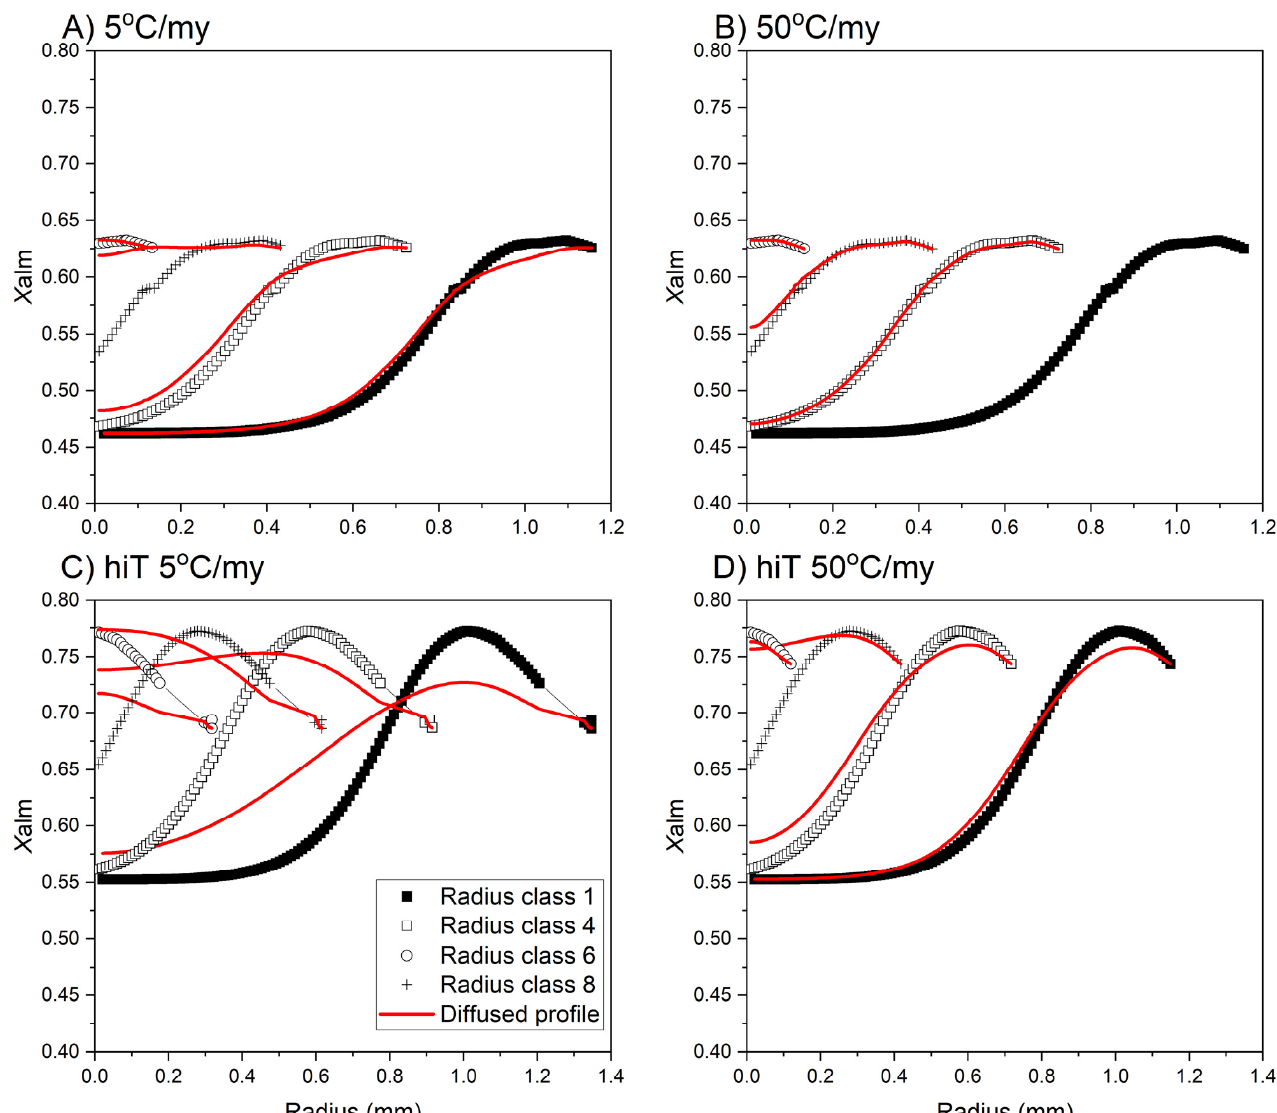
Figure 5. Compilation of the Theria_G modeled almandine mole fractions for radii classes 1, 4, 6, and 8. Radius is the distance in mm from the core. Symbols represent model-predicted initial prograde growth profiles that are not impacted by intracrystalline diffusion, whereas the solid red lines correspond to the final diffusion-impacted profiles. Each panel is a separate simulation unique in heating/cooling rate and/or input P-T path. ( A ) Results for a simulation evolved along [26] path “B” at a heating/cooling rate of 5 °C/my. ( B ) evolved along [26] path “B” at a heating/cooling rate of 50 °C/my. ( C ) evolved along the hiT path (Figure 3B) with a heating/cooling rate of 5 °C/my. Panel ( D ) evolved along the hiT path with a heating/cooling rate of 50 °C/my. All data are plotted at the same y-scale for ease of comparison.